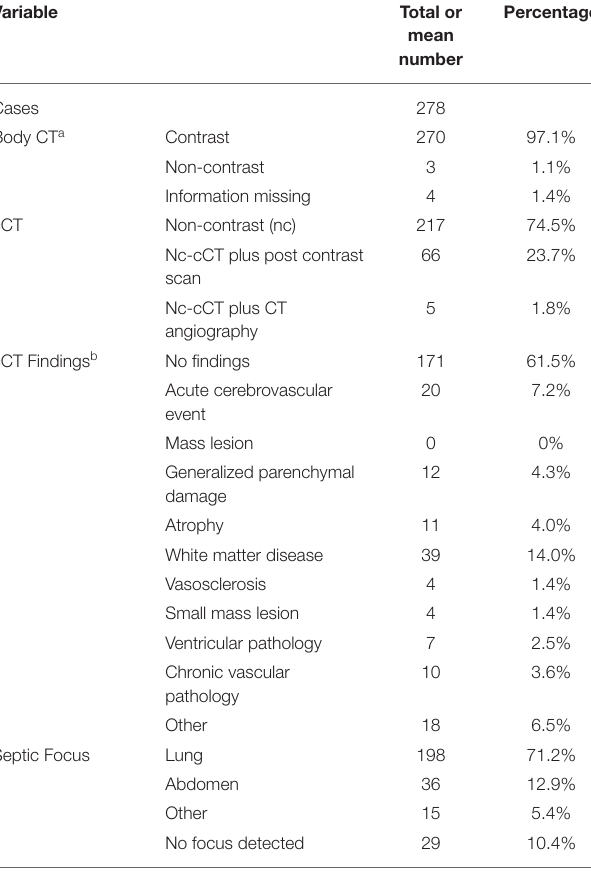
TABLE 1 | Patient characteristics; a total of 213 patients were analyzed. Further analysis included 278 CT